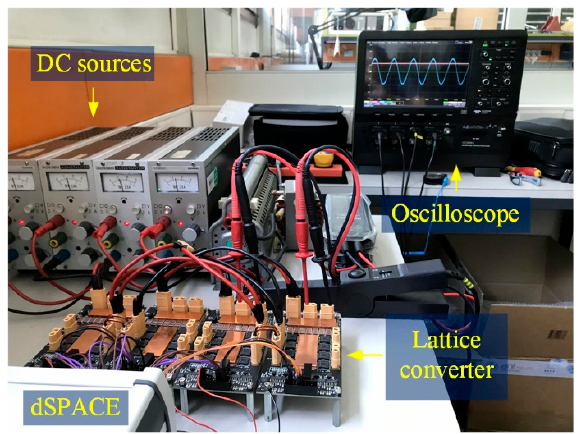
Figure 16. Photo of the experimental setup.